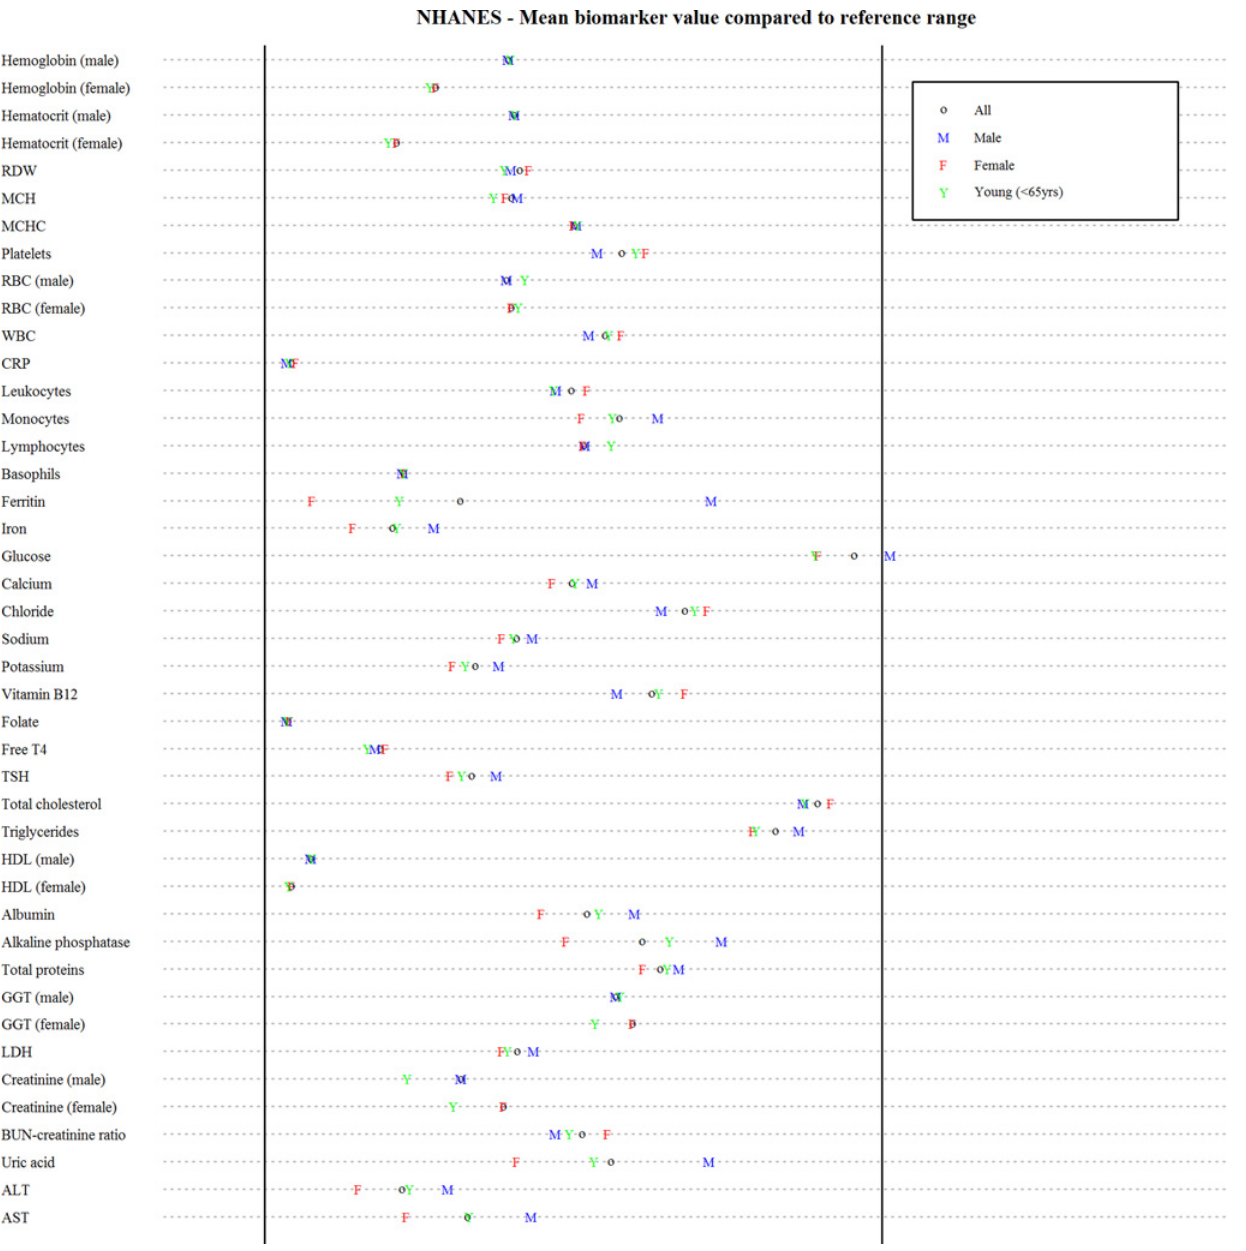
Fig 1. Mean biomarker values for NHANES in relation to reported reference ranges. Mean values for each biomarker were normalized according to the reported minimal and maximal normal values, represented by the vertical lines. For biomarker with only one specified normal value, the other vertical line represents minimal or maximal value for the data set (see S1 Table for details). Graphs for other data sets can be found in S1 – S3